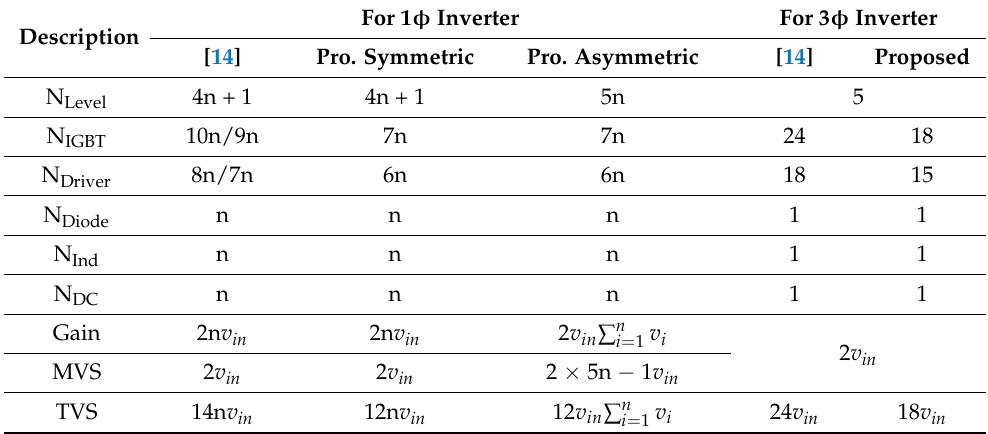
Table 1. Comparison of proposed topology and